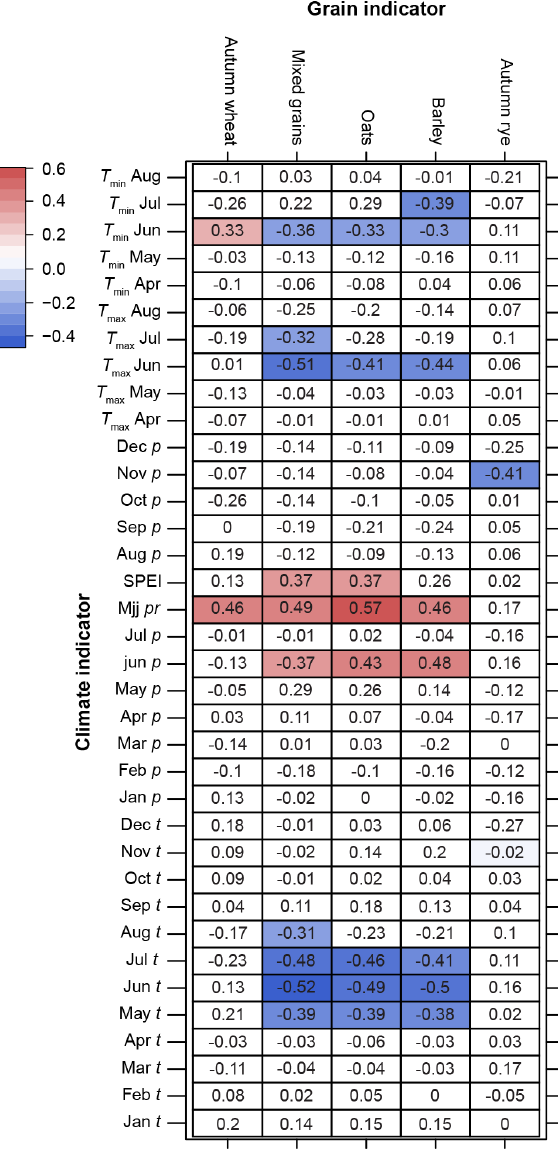
Figure 11. Correlations of grain series vs. climate indicators 1865– 1911. Note: Only statistically significant ( p ≤ 0 . 05) correlations are colored. Sources: SCB (2021), Seftigen et al. (2017, 2020), and SMHI